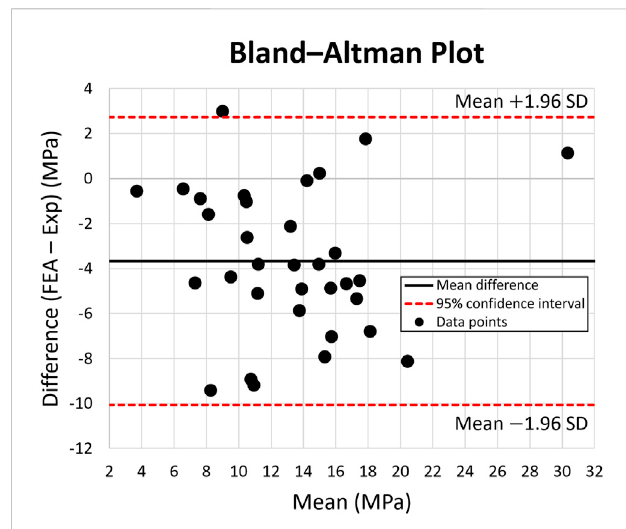
FIGURE 6 Bland-Altman Plot for von Mises stress across 10 points of interest on the intact bone, solid stem, and porous stem. The dotted lines represent 95% con fi dence intervals. Black data points represent the mean and variation (bias) between the von Mises stress obtained experimentally and through FE modeling, from each point of